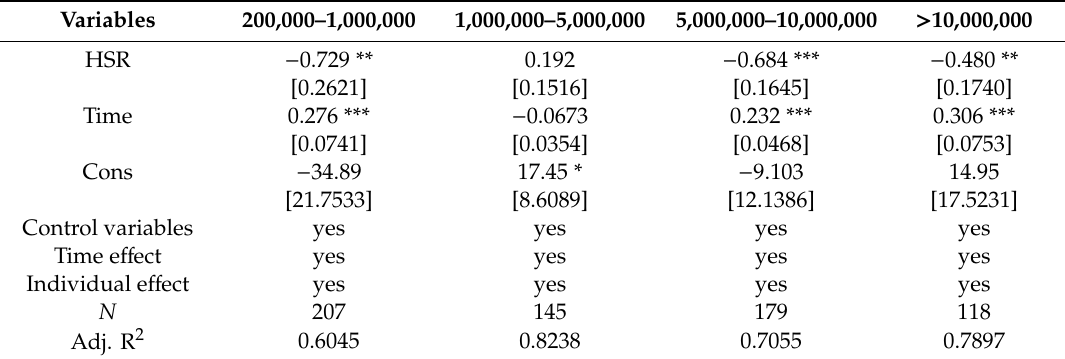
Table 6. Test of the direct effect of the HSR considering the heterogeneity of city scale. Variables